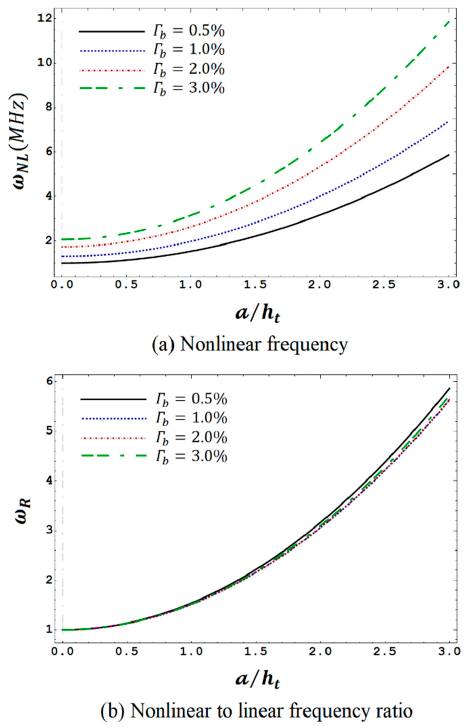
Figure 4. Variation of the first-order nonlinear frequency and nonlinear-to-linear frequency ratio of a GPL-reinforced sandwich beam with respect to an increasing amplitude of vibrations, and for a di ff erent total amount of GPLs in the beam ( h c / h t = 0.6, N = 10, a / h t = 1, L / h t = 10, κ = 2 ).